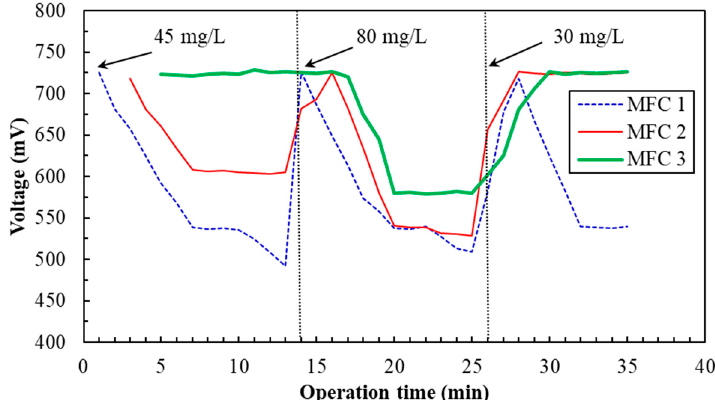
Figure 6. Effect of Cr(VI) concentrations sequentially fed to the system on the voltage output of the three-stage SCMFC biosensor inoculated with E. aestuarii YC211 in continuous-flow operation (liquid retention time: 2 min, stable time: 6.6 min, external resistance: 500 Ω ). Table 1. Cr(VI) measurement from effluents of eight leather processing units by three-stage SCMFC biosensor in continuous-flow operation and colorimetric method in batch operation. .